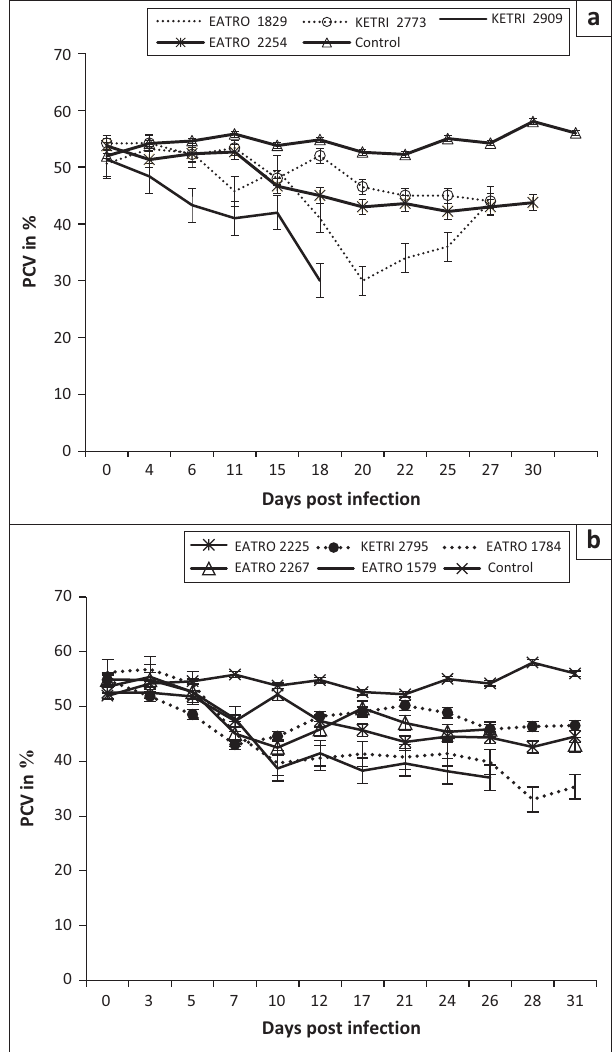
FIGURE 1: Parasitaemia patterns in mice infected with (a) Trypanosoma congolense isolates and (b) Trypanosoma brucei isolates.